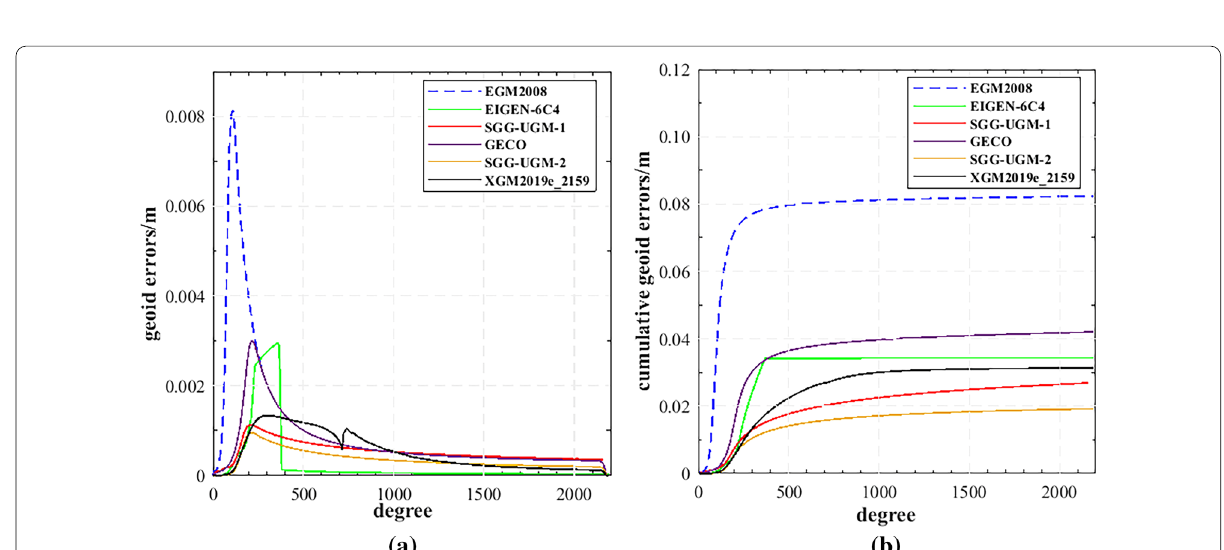
Fig. 2 Results of the internal error